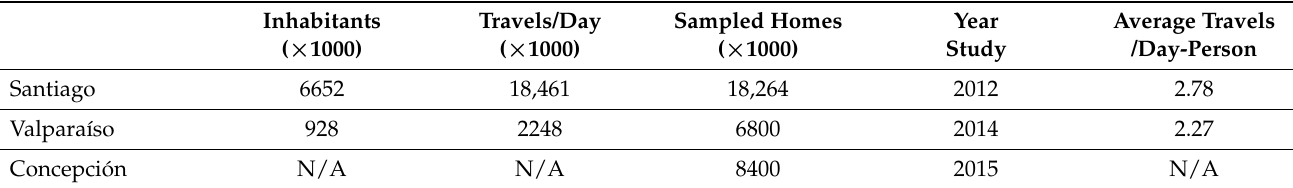
Table 5. General status of Origin-Destination Survey (ODS) in the main areas of Chile. The case of Concepción shows us that surveys do not always reach the expected